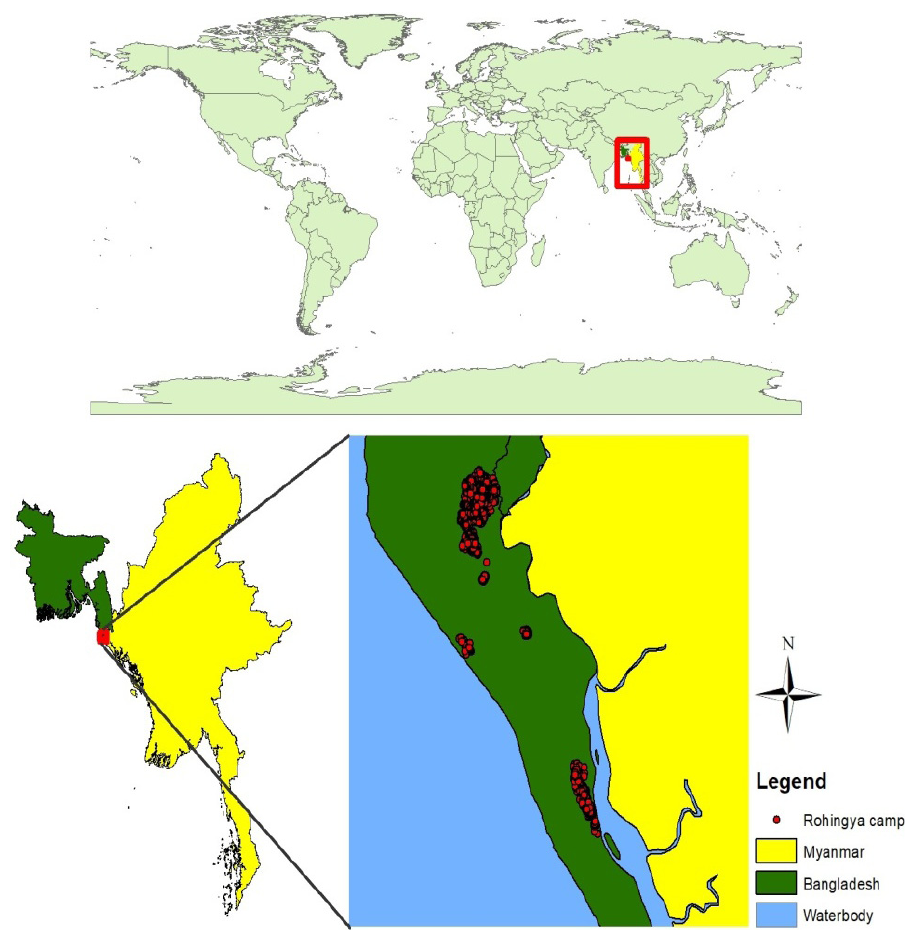
Fig. 1. Study area in southeastern border region of